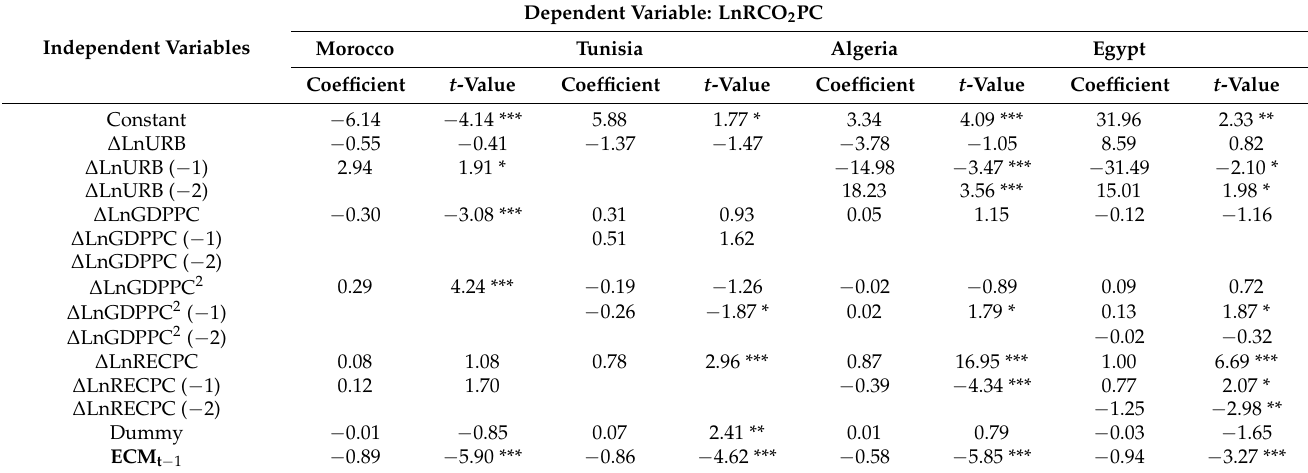
Table 6. Short-run estimates; the dependent variable is LnRCO 2 PC emissions.